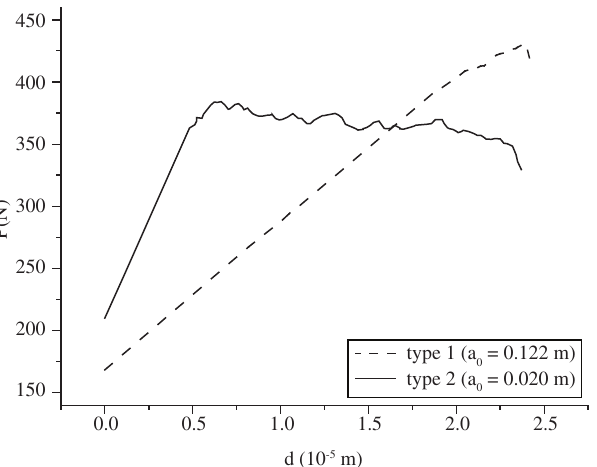
Figure 9. Two different types of P-d curve.